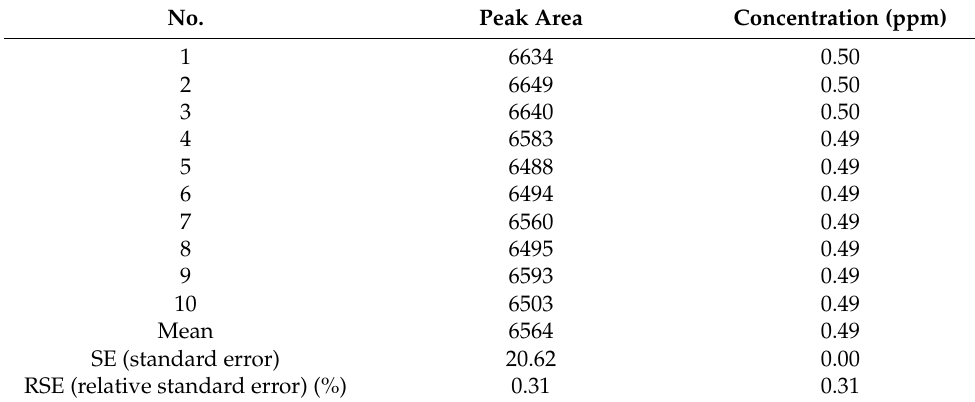
Table 4. Validation of reproducibility of